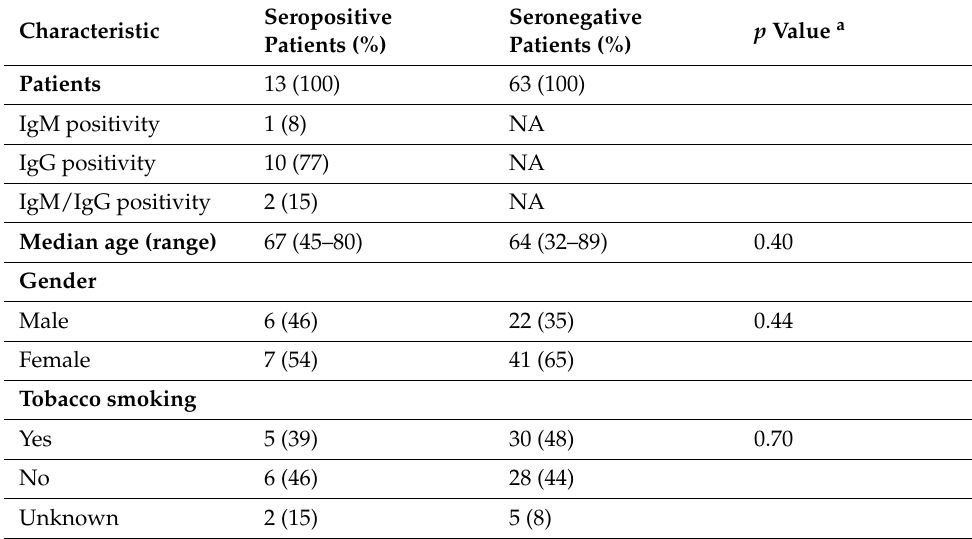
Table 2. Characteristics of cross-checked seropositive and seronegative